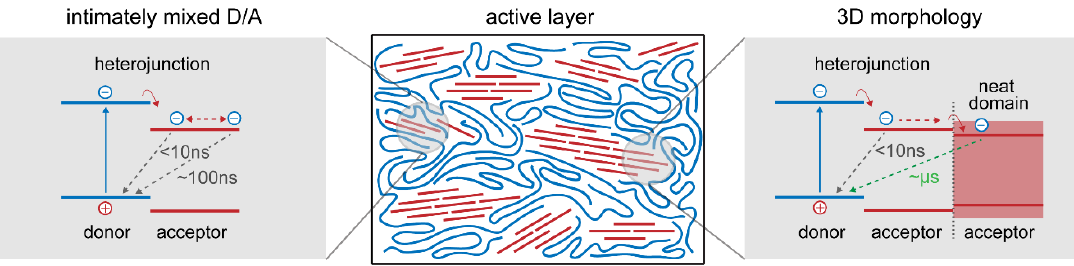
Figure 3. Illustration of the functional model for charge generation and recombination.